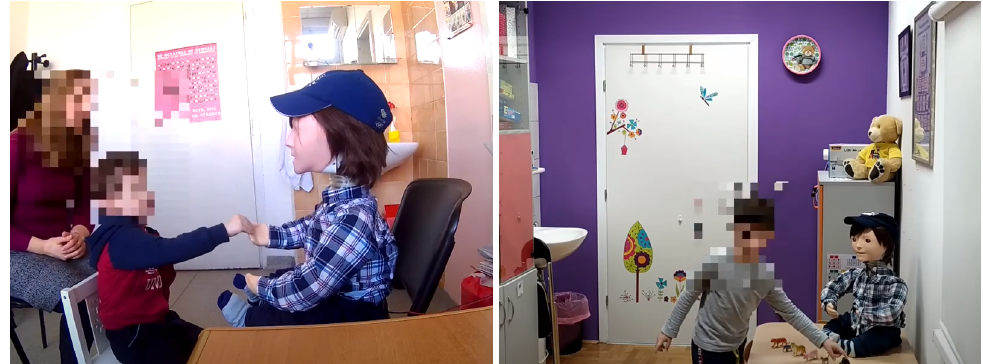
Figure 1. Therapeutic sessions with the Kaspar robot.